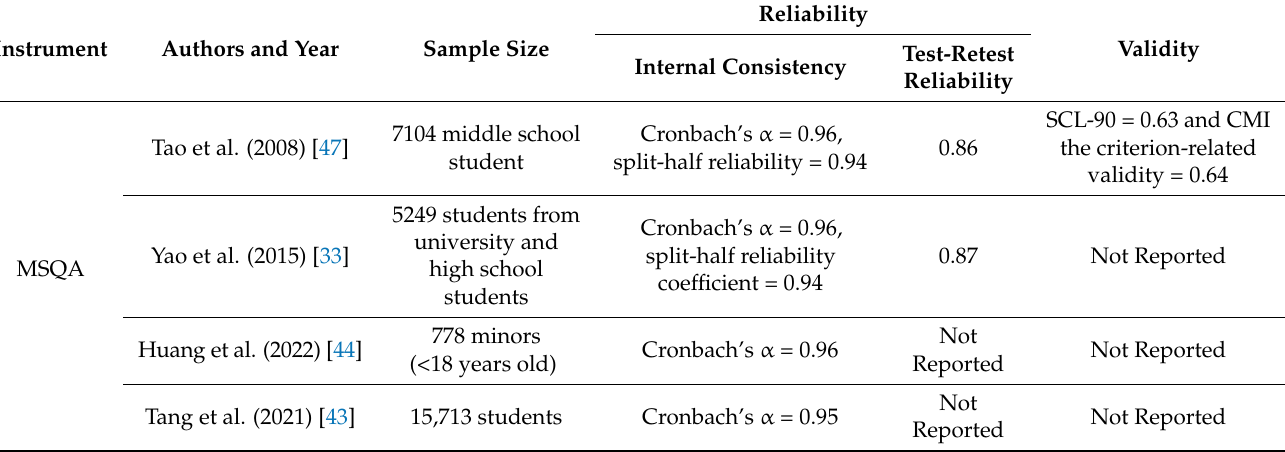
Table 3. Studies on reliability and validity of the MSQA and